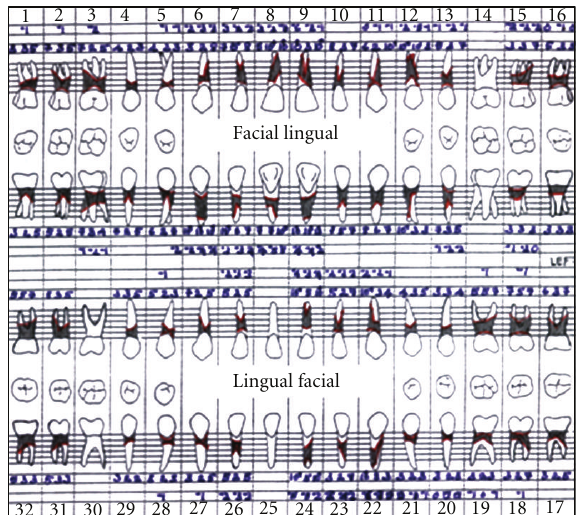
Figure 10: Pretreatment periodontal charting shows deep pockets with generalized clinical attachment loss.